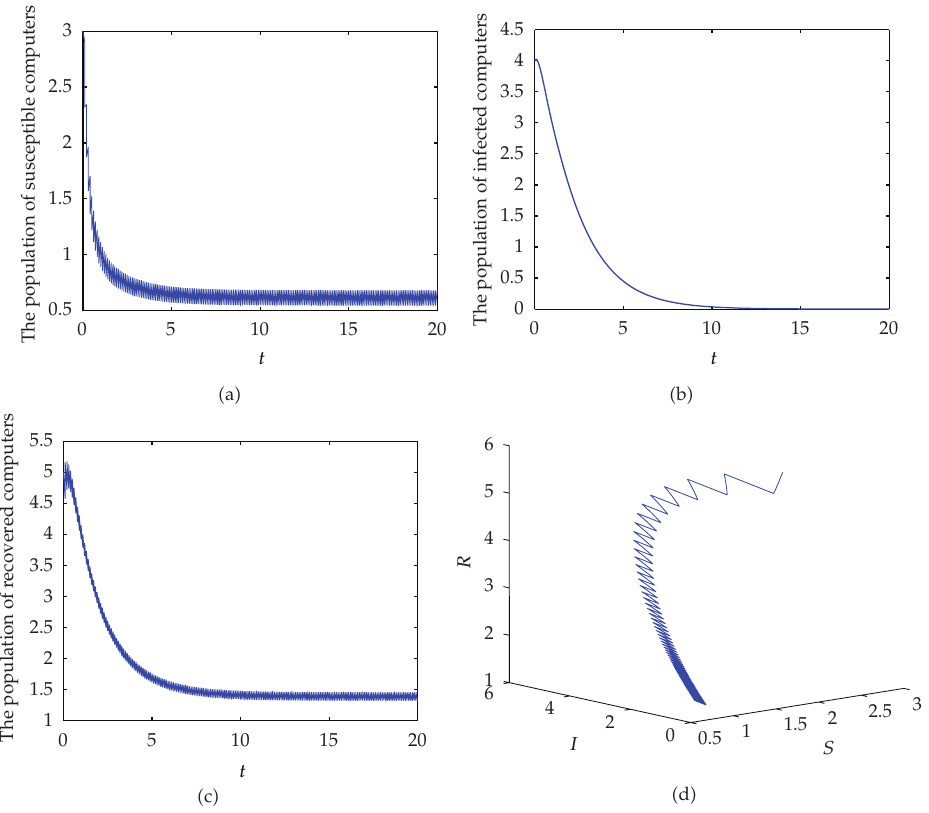
Figure 3: Global attractivity of infection-free periodic